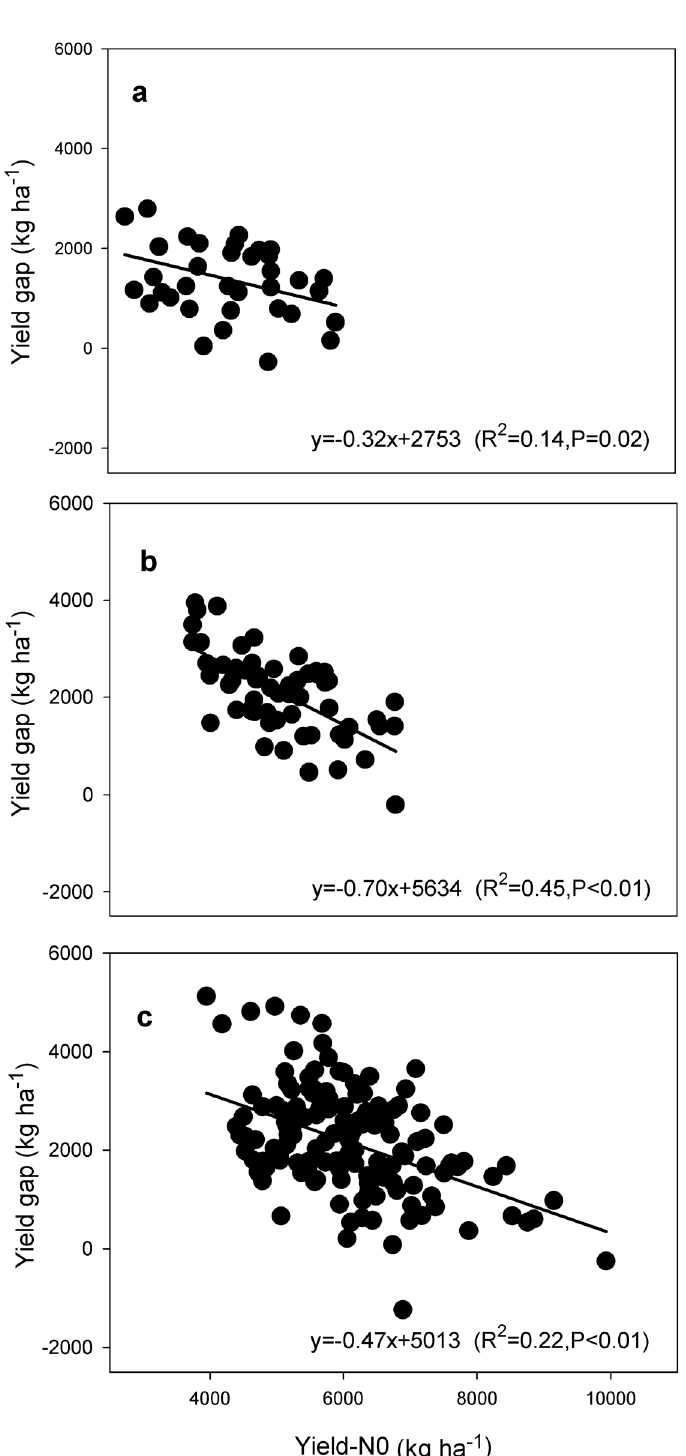
Fig 3. Relationships among management practices, soil inherent productivity and yield gap. Note: soil inherent productivity was estimated as yield in zero-N plots (Yield-N0). Yield gaps were estimated as differences between yields in farming practice on soils with various productivity levels and ‘ attainable yields ’ , determined as mean yields of the 20% highest-yielding locations under BMPs. (a), early rice (n = 98); (b), late rice (n = 148); (c), single rice (n =